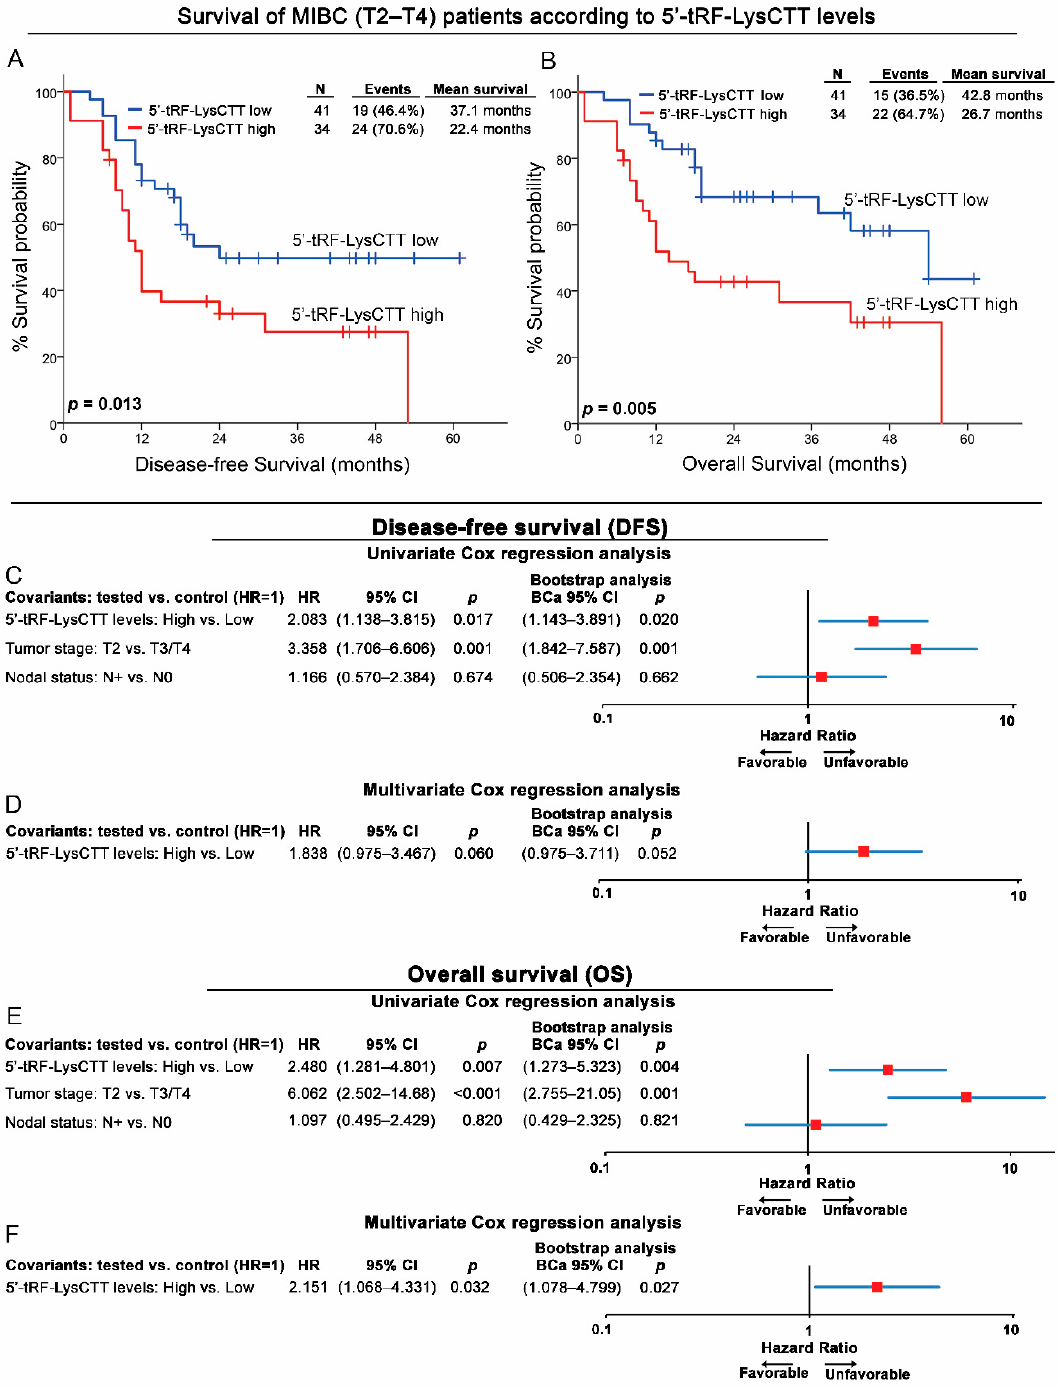
Figure 5. Elevated 5 ′ -tRF-LysCTT levels in MIBC (T2-T4) patients are strongly correlated with worse disease-free survival (DFS) and overall survival (OS) following treatment. ( A , B ) Kaplan–Meier survival curves for the disease-free survival (DFS; a) and overall survival (OS; B) of the MIBC (T2–T4) patients according to 5 ′ -tRF-LysCTT levels. p -values calculated by log-rank test. ( C – F ) Forest plots of the univariate and multivariate Cox regression analysis for the MIBC (T2–T4) patients’ PFS ( C , D ) and OS ( E , F ). Multivariate analysis adjusted for 5 ′ -tRF-LysCTT levels, tumor stage and nodal status. Internal validation was performed by bootstrap Cox proportional regression analysis based on 1000 bootstrap samples. HR: Hazard Ratio, 95% CI: 95% confidence interval of the estimated HR, BCa 95% CI: bootstrap bias-corrected and accelerated 95% confidence interval of the estimated HR based on 1000 bootstrap samples.